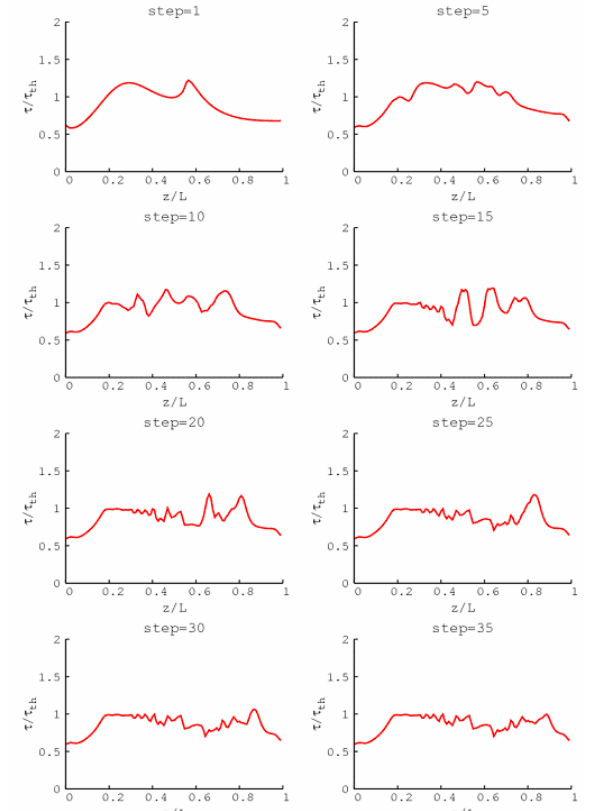
Fig. 9 Plot of the evolution of the WSS distribution for the curved model. Simulation condition: k=1.5 and τ =50 dyne/cm 2 (5.0 th